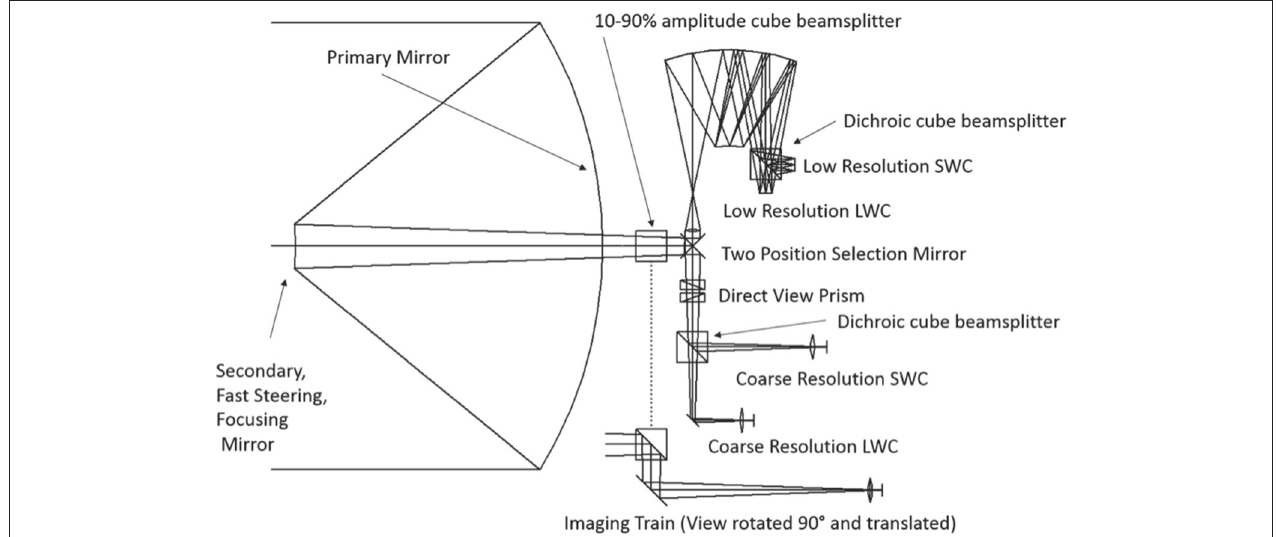
FIGURE 6 | Optical layout of the NIRT showing the imaging (Direct; 0.7–2.0 µ m), coarse resolution short-wave (SWC; 0.7–1.35 µ m), and long-wave (LWC; 1.35–2.0 µ m) channels, and the R ∼ 1,000 spectrograph. This design offers high throughput while providing arcsec-level imaging for GRB localization, rapid redshift determination, and spectroscopic follow-up.